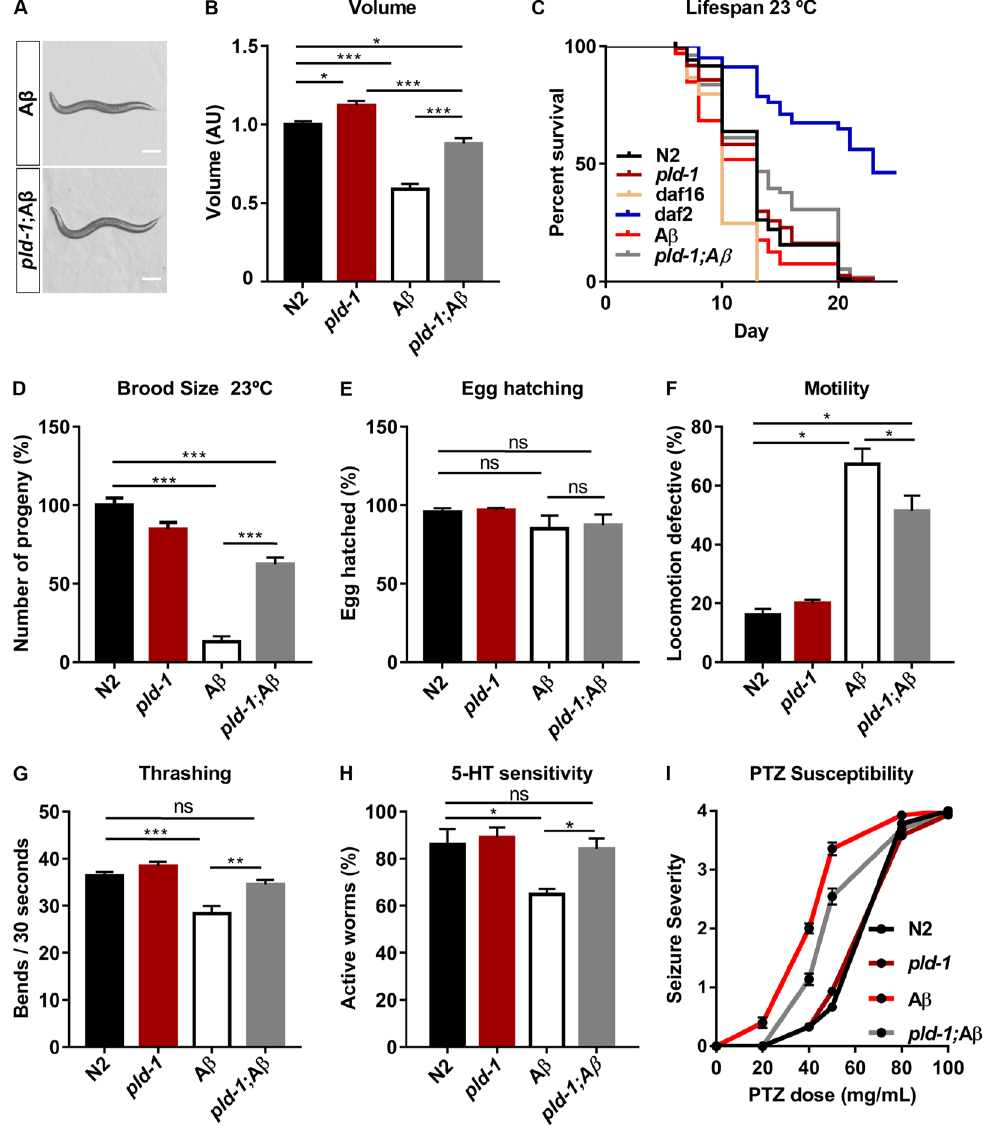
Figure 4. PLD functional ablation ameliorates A β induced phenotypes. ( A ) Representative photos of A β and pld-1 ;A β and volume ( B ) of N2, pld-1 , A β and pld-1 ;A β animals at day 3 after egg laying. The scale bar represents 100 µ m. ( B ) A β transgenic worms have a decrease in body size, which is partially renormalized upon PLD ablation. The data results from the analysis of 45 worms per strain in 4 independent experiments. Values denote means ± SEM. ( * p ≤ 0.05, ** p ≤ 0.01, *** p ≤ 0.001). ( C ) Effects of neuronal A β expression on adult lifespan at 23 °C. The experiment was conducted twice with 100 worms per strain. Representative example of two independent experiments is shown. Kaplan-Meier survival curve of A β and pld-1 ; A β worms, showing differences in the median lifespan compared with N2 and pld-1 animals. The mean adult lifespan of pld-1 ; A β animals was significantly longer than A β transgenic animals. ( D – I ) Neuronal expression of A β in C . elegans leads to a defect in brood size( D ), locomotion ( F ), decrease in thrashes over time ( G ), serotonin sensitivity ( H ) and pentylenetetrazol (PTZ) susceptibility ( I ), when compared to the N2 and pld-1 animals. ( D ) Improvement in brood size due to ablation of PLD in A β animals. Total number of progeny of adult hermaphrodite N2, pld-1 , A β and pld-1 ; A β worms for 8 days. The progeny of 15 worms was counted per experiment (n = 2). ( E ) Egg viability was not significantly affected by neuronal expression of A β (n = 3). ( F ) A β worms have a motility defect partially recovered by PLD ablation. Percentage of uncoordinated N2, pld-1 , A β and pld-1 ; A β adult hermaphrodite animals was measured by scoring the animals that remain inside 10 mm circle after 1 min (n = 4 experiments, 10 worms per strain and experiment). ( G ) The number of body thrashes per 30 seconds was partially rescued by PLD ablation in A β transgenic animals (n = 4 experiments, 10 worms per strain and experiment). ( H ) PLD ablation in A β animals leads to a decrease in hypersensitivity to 1 mM serotonin caused by A β (n = 4 experiments, 60 worms per strain and experiment). ( I ) PLD ablation reduces seizure-severity induced by PTZ in A β transgenic worms. PTZ susceptibility of worms were scored after exposure to the concentrations of 20, 40, 50, 80 and 100 mg/mL of PTZ (n = 4 experiments, 15 animals per dose/strain/experiment). Values denote means ± SEM. ( * p ≤ 0.05, ** p ≤ 0.01, *** p ≤